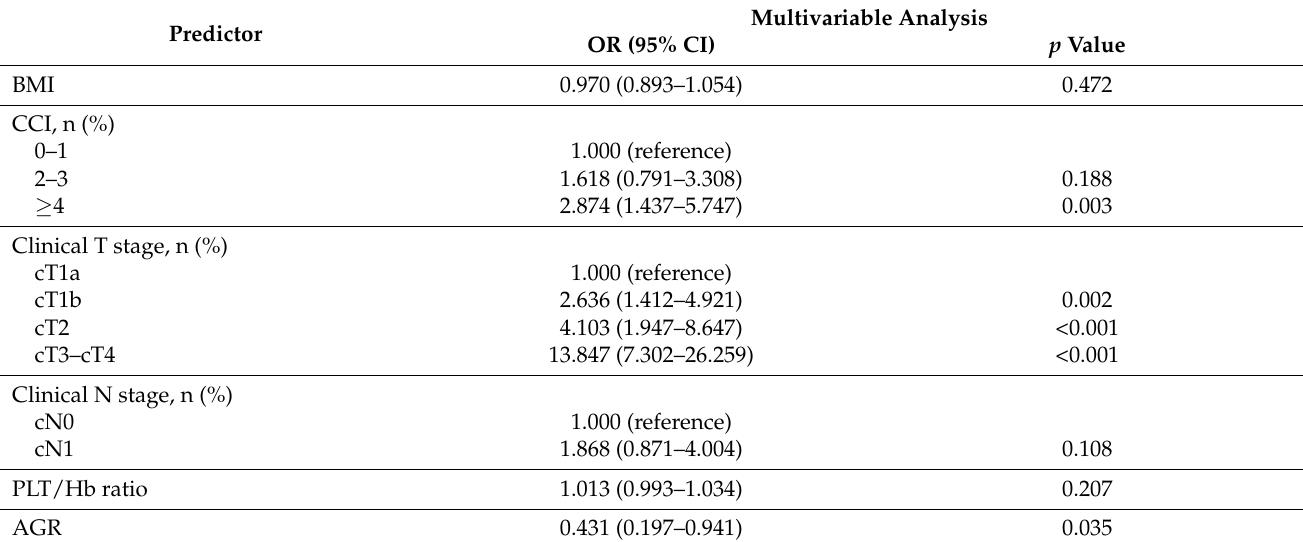
Table 3. Multivariable logistic regression analysis predicting positive chest computed tomography scans in patients with renal cell carcinoma selected for surgical treatment for kidney cancer.